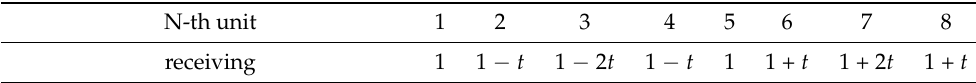
Table 4. Relative amplitude coefficients of the receiving array (second type).